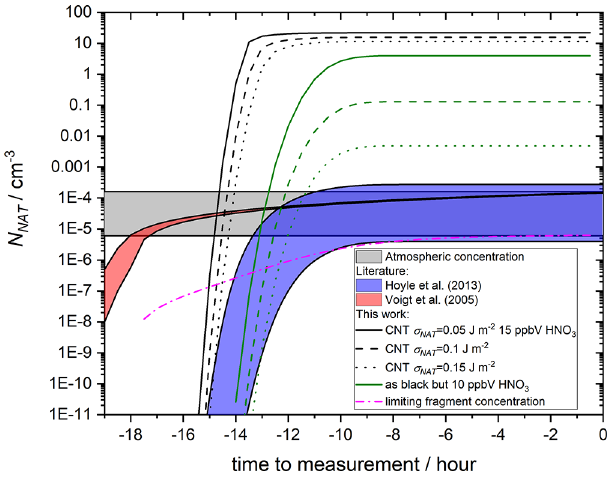
Figure 11. NAT particle production using a temperature profile based on stratospheric observations from Voigt et al. (2005). See James et al. (2018) Fig. 6a for corresponding temperature and sat- urations. S NAT were calculated at 70hPa assuming 5ppmVH 2 O, 0.1ppbVH 2 SO 4 and 10 (minimum of ranges and green lines) to 15 (maximum of ranges and black lines) ppbVHNO 3 . Growth, sed- imentation of particles and removal of HNO 3 are not taken into account. These processes will limit the number of NAT particles that can nucleate by reducing the HNO 3 concentration and NAT saturation in remaining droplets, hence our predicted NAT num- ber concentrations are an upper limit. Predicted N NAT based on nucleation parameterisations from this work compared to James et al. (2018) and estimated surface areas and size distributions of MSPs as well as two literature parameterisations (Voigt et al., 2005; Hoyle et al., 2013). The CNT parameterisation produced in this work is shown for a range of surface energy ( σ NAT ) values differen- tiated by line type, using paired contact angles constrained by het- erogenous nucleation experiments. Crystal number concentrations calculated from a parameterisation of meteoric fragments are also shown, with the availability of fragments varied to reproduce the lowest observed atmospheric